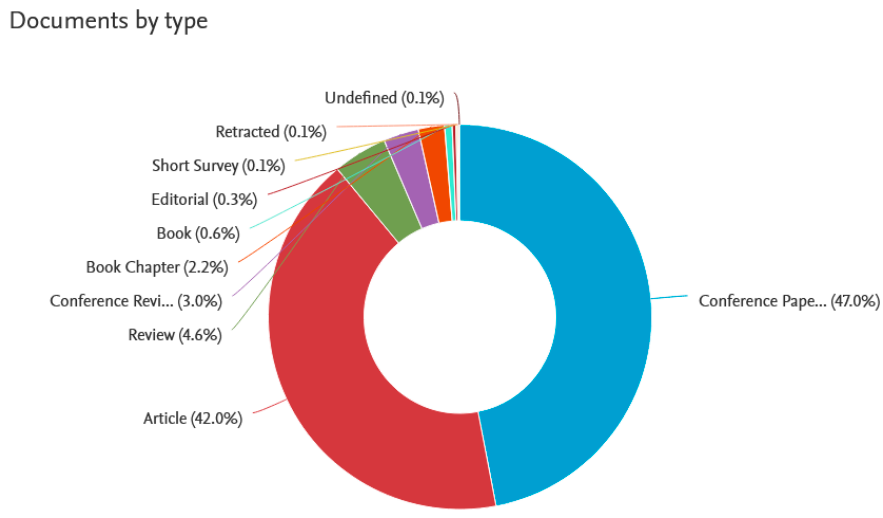
Figure 10. Documents found in Scopus for the “big data mining” key phrase by document type.